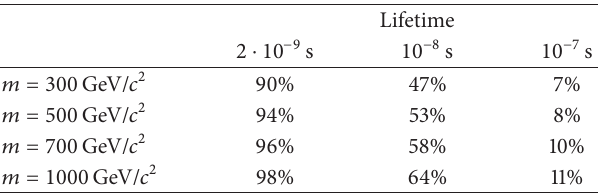
Table 8: Fraction of rejected decays of heavy quarks within the geometrical acceptance of the CMS tracking detector. Decays within the tracker are rejected because the particle’s trajectory does not reach the outermost tracker layers.